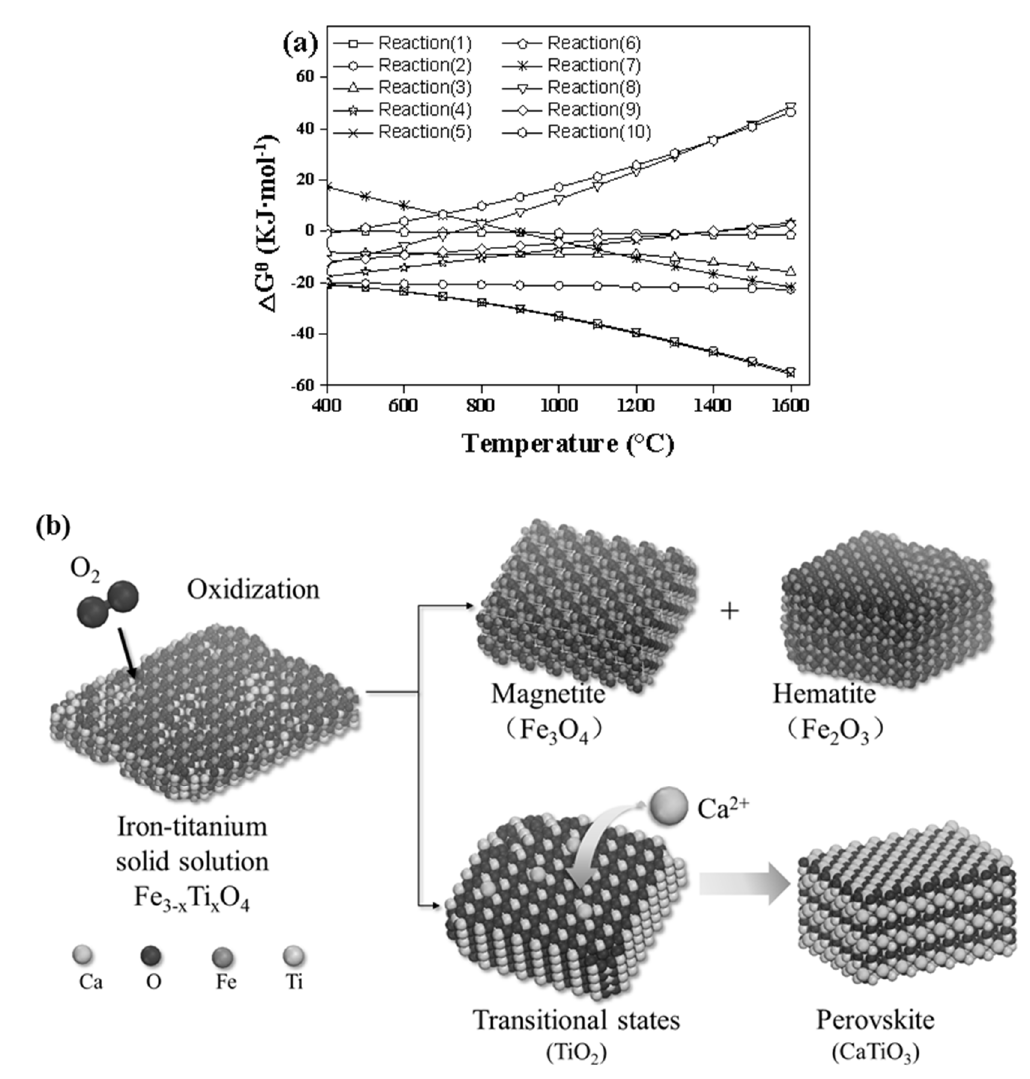
Figure 4. ( a ) Relationships between the change of Gibbs free energy and the temperature of reactions (1) − (10). ( b ) Ore phase transformation of iron-titanium solid solution oxidation.